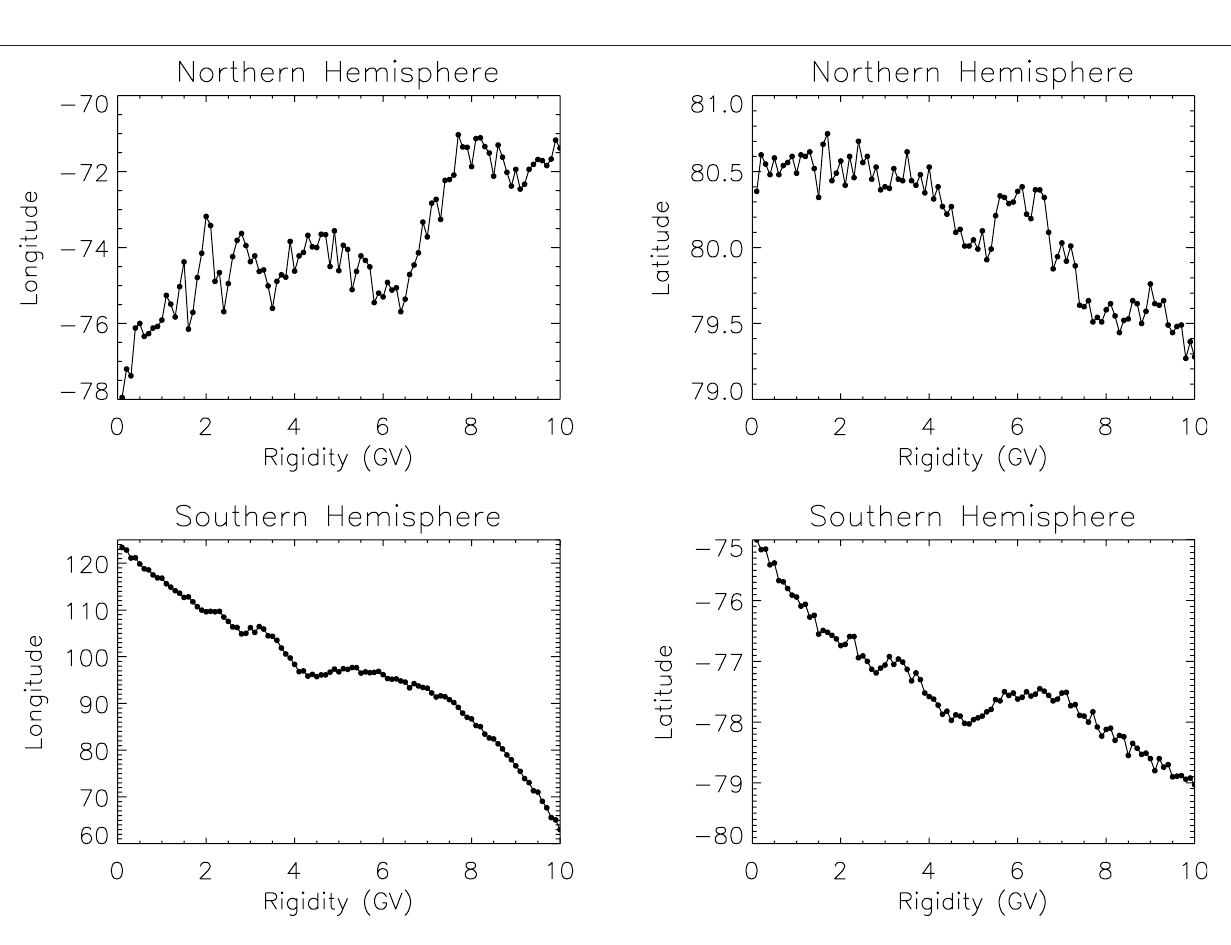
FIGURE 15 | Central location of the EPW for different rigidities.